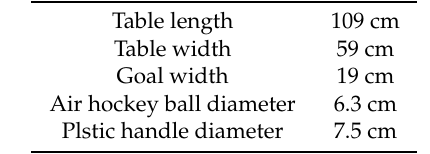
Figure 20. Stepping motor 42BYGH4417 NEMA 17. In addition, the pixel of the camera is set to 640 × 480 and the operating system of the personal computer (PC) is Windows 10. The PC hardware equipment is listed in Table 2. Table 2. Hardware equipment. Memory